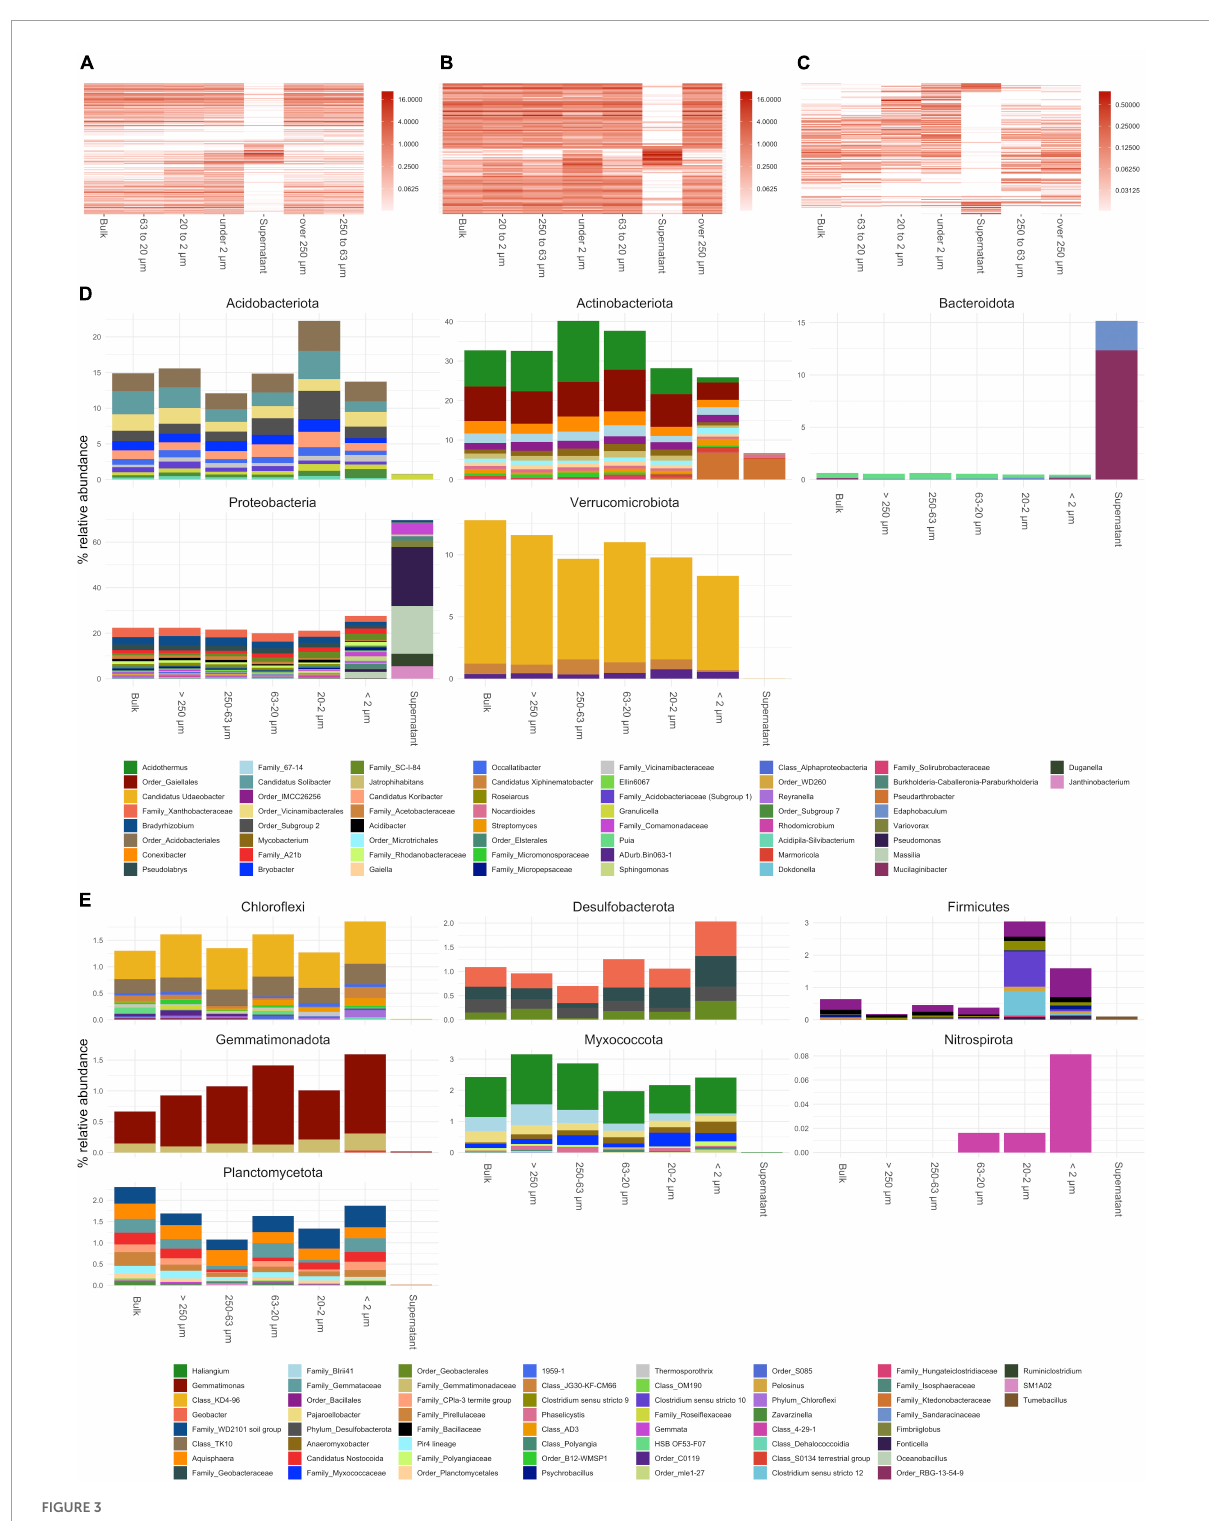
FIGURE3 Annotated bacterial amplicon sequence variants (ASVs) of small subunit (SSU) rRNA gene amplicons collapsed to genus level. (A–C) Show heatmaps of all genera detected, genera present over and under 1% in relative abundance, respectively. Order of x and y-axis of heatmaps are based on a PCoA ordination of unweighted unifrac distances. (D) Bar plots of higher abundant phyla showing genera over 0.3% in relative abundance. (E) Bar plots of lower abundant phyla (unfiltered). If taxa unit could not be annotated at the genus level the name of the last higher rank where an annotation at a bootstrap value of 0.8 was possible is